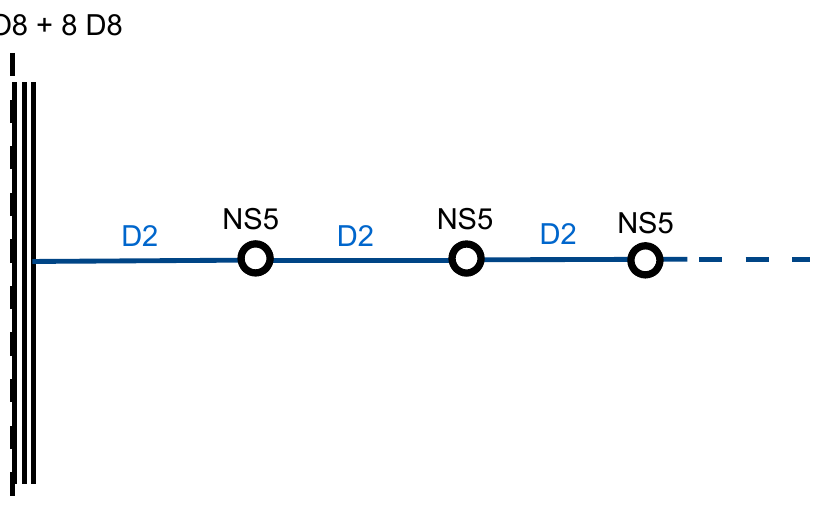
Figure 6 . Brane con(cid:12)guration for the theory of N small E